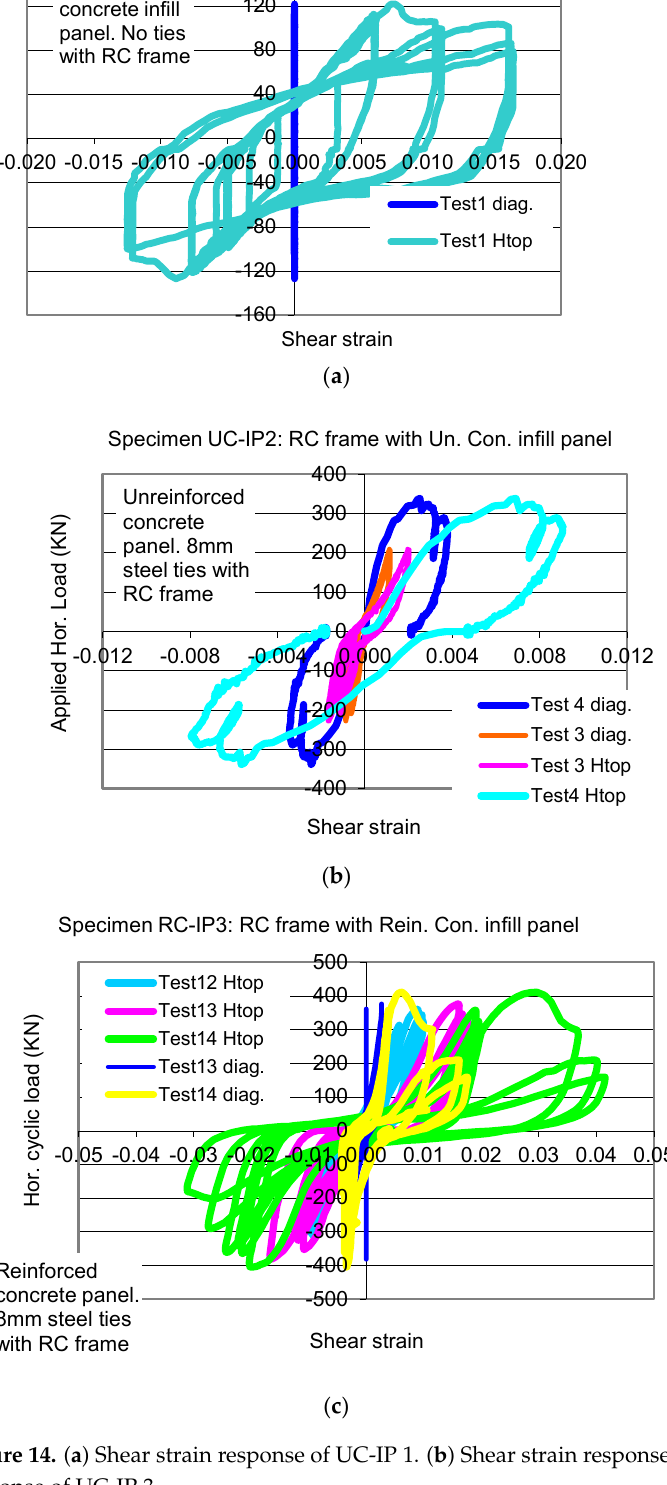
Figure 14. ( a ) Shear strain response of UC-IP 1. ( b ) Shear strain response of UC-IP 2. ( c ) Shear strain response of UC-IP 3.